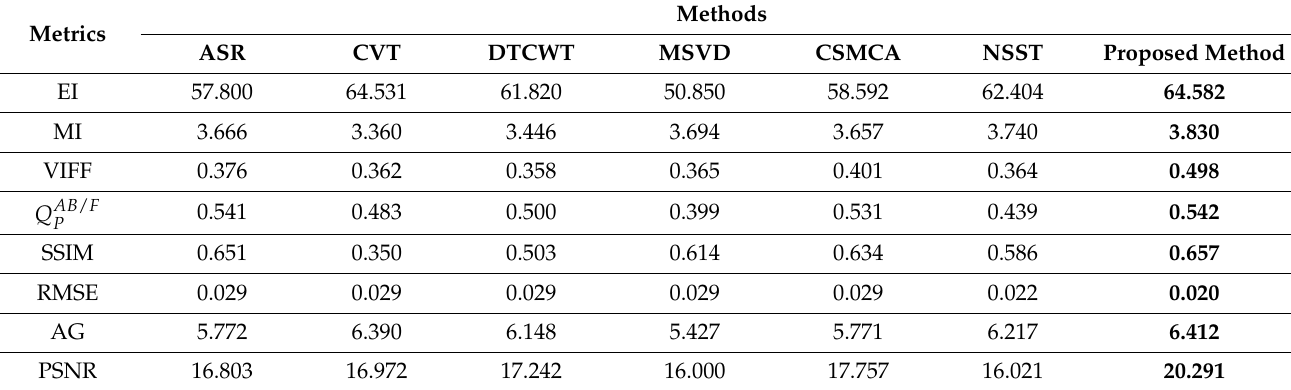
Table 6. Average quantitative analysis of the proposed method (23 pairs of MRI-CT) and other state-of-the-art methods.